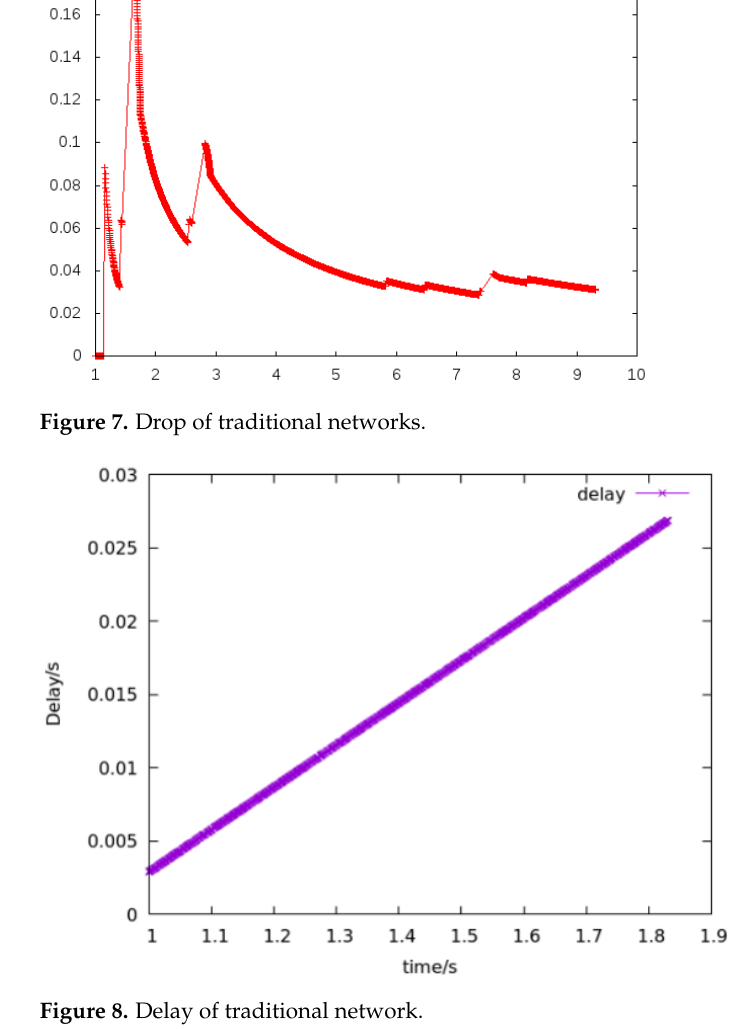
Figure 9. NDN network throughput.